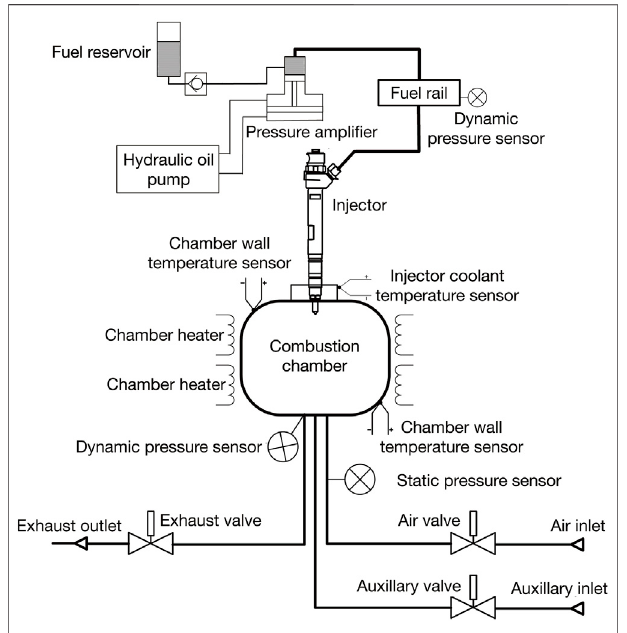
FIGURE 1 | Schematic overview of the Combustion Research Unit (CRU).